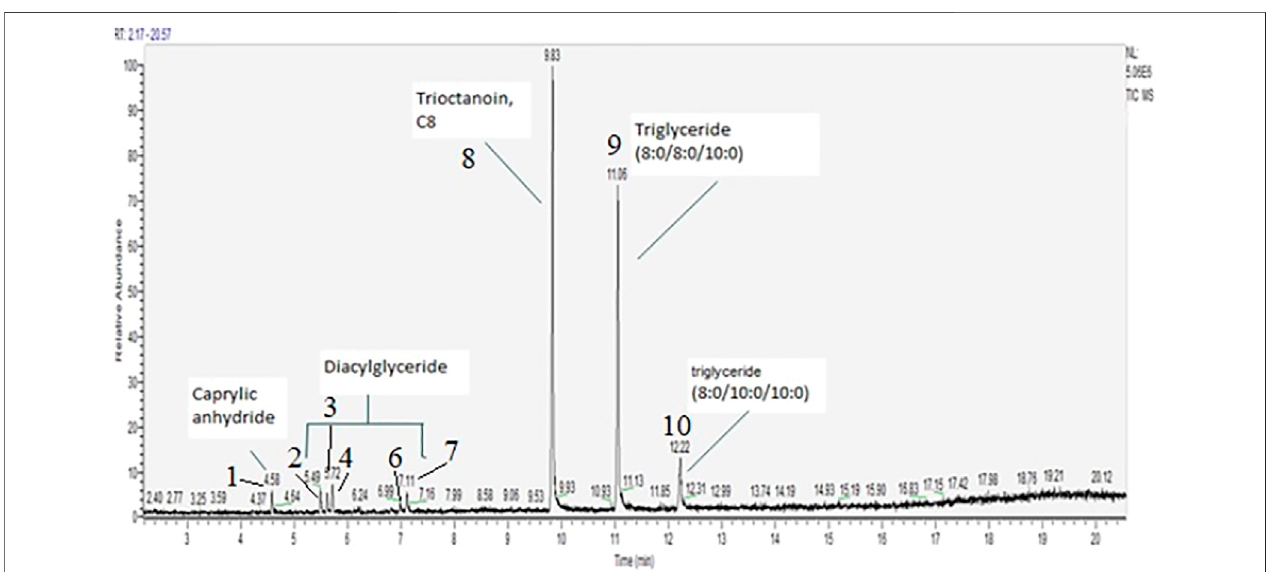
FIGURE 3 | MCT oil emission scan, concentration 920